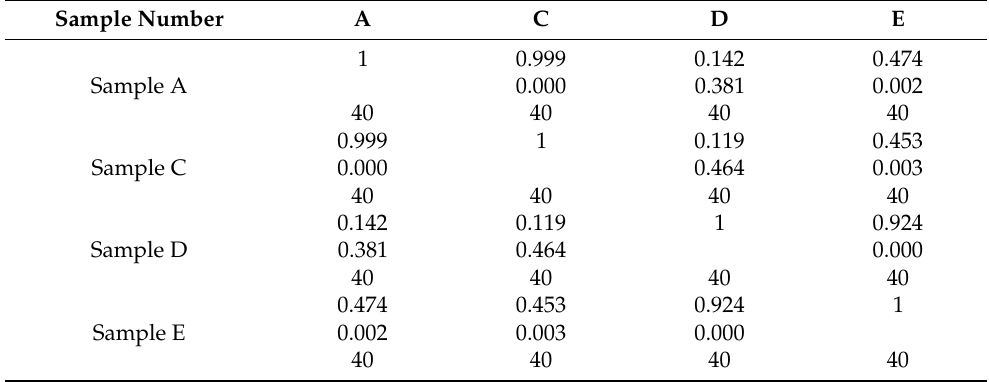
Table 10. Correlation test of the Mayuan Zn-Pb deposit (Pearson correlation significance).